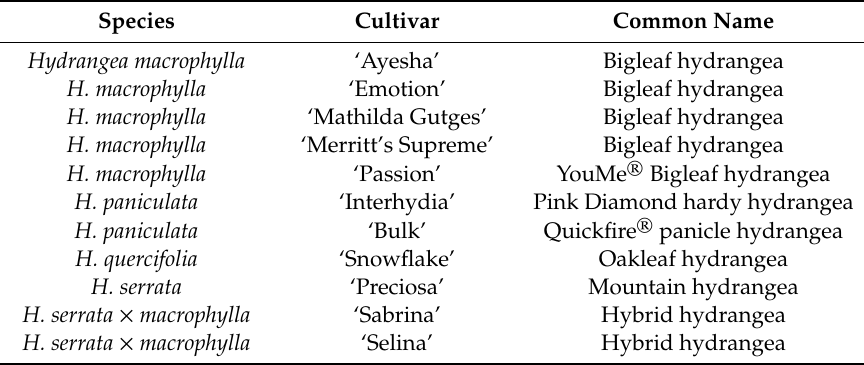
A list of hydrangea cultivars irrigated with a nutrient solution or saline